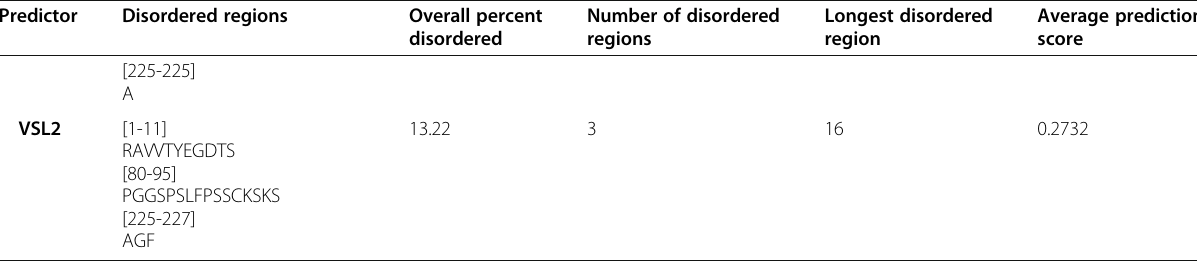
Table 2 The predicted percentage of intrinsic disorder scores of YDR in hepatitis E viruses (Continued) Predictor